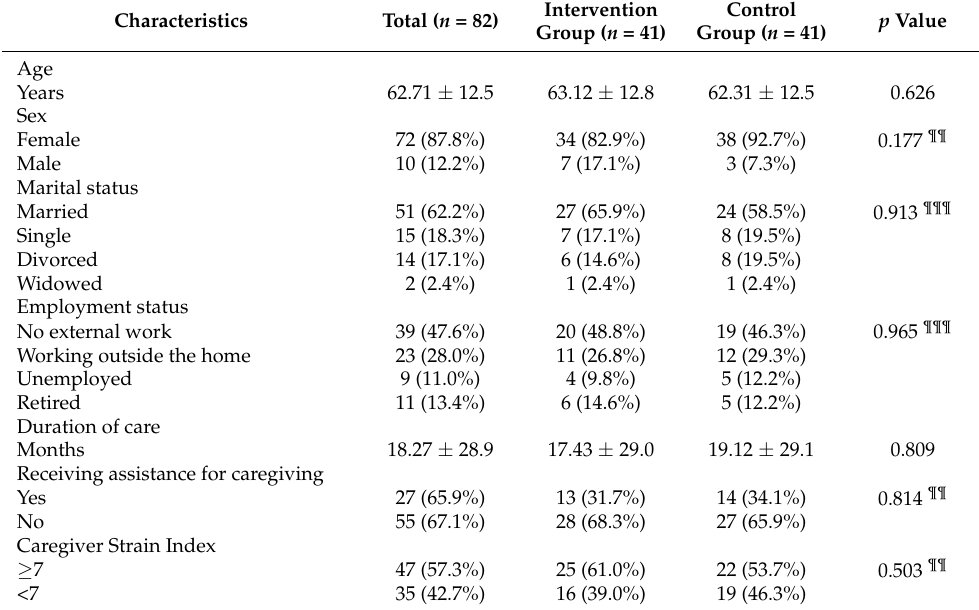
Table 2. Bivariate analysis of socio-demographic data for caregivers of palliative cancer patients. Characteristics